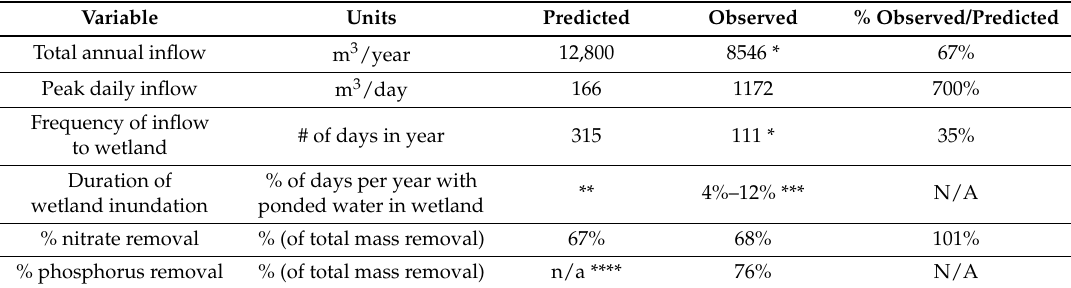
Table 8. Summary comparison of predicted and observed results for hydrologic and water quality performance of treatment